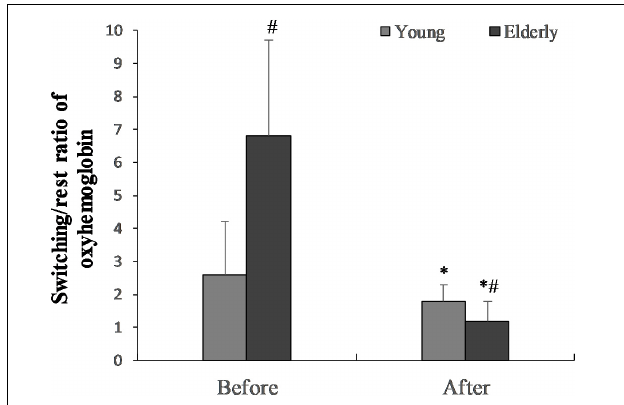
FIGURE 5 | The switching/rest ratio of oxygenated hemoglobin before the “Go/NoGo” task in the young and elderly men. ∗ p < 0.05 compared with before the “Go/NoGo” task; #p < 0.05 compared with the young men.